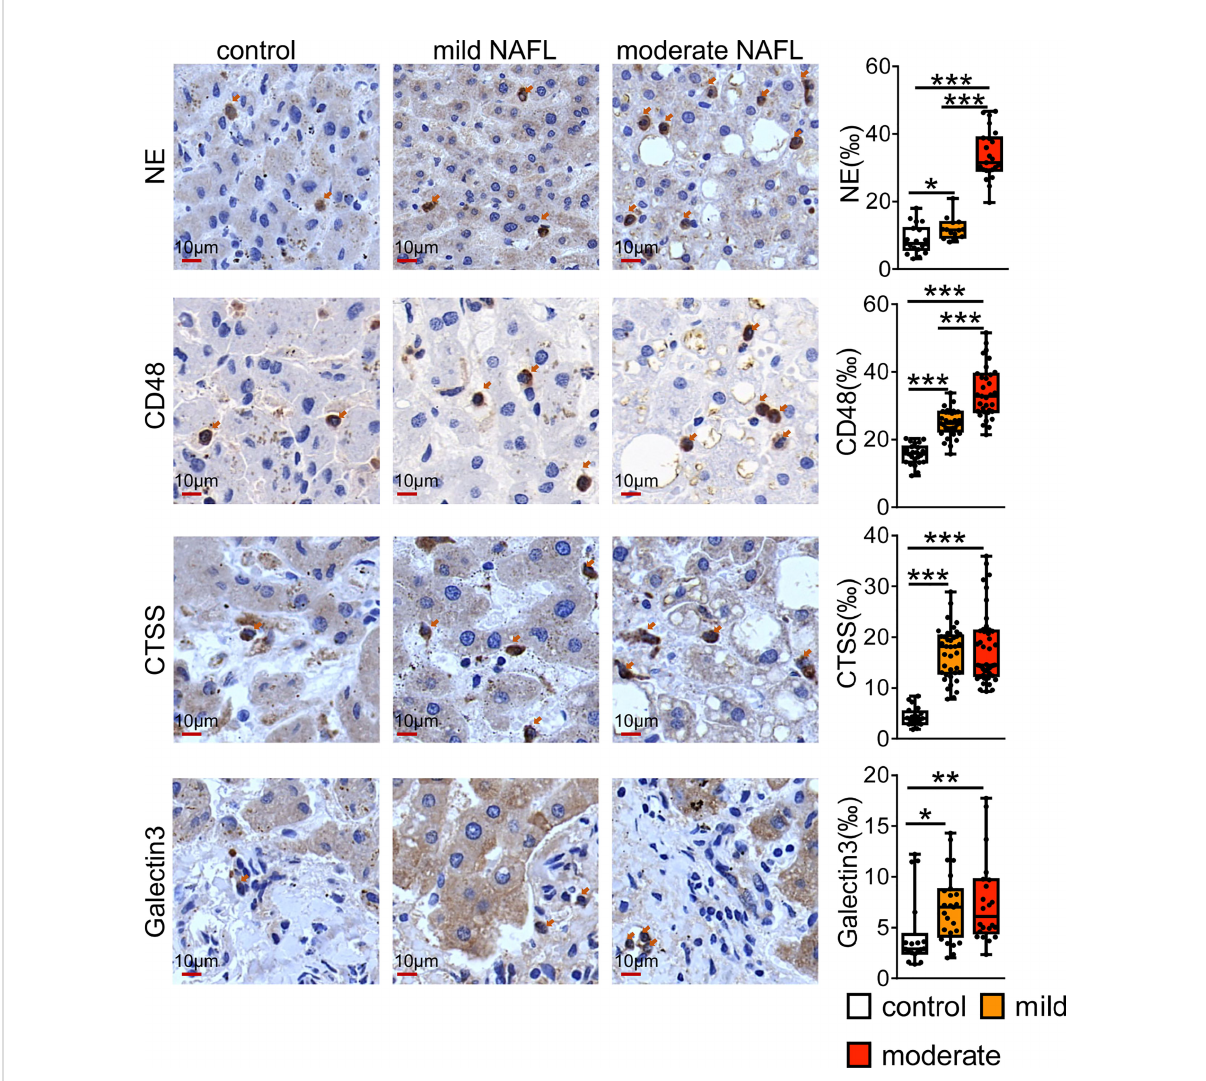
FIGURE 7 Immunostaining for CD48, NE, CTSS and Galtectin3 in human NAFL liver. Bars = 10 m m (×100). * P < 0.05, ** P < 0.01, *** P <0.001, vs.